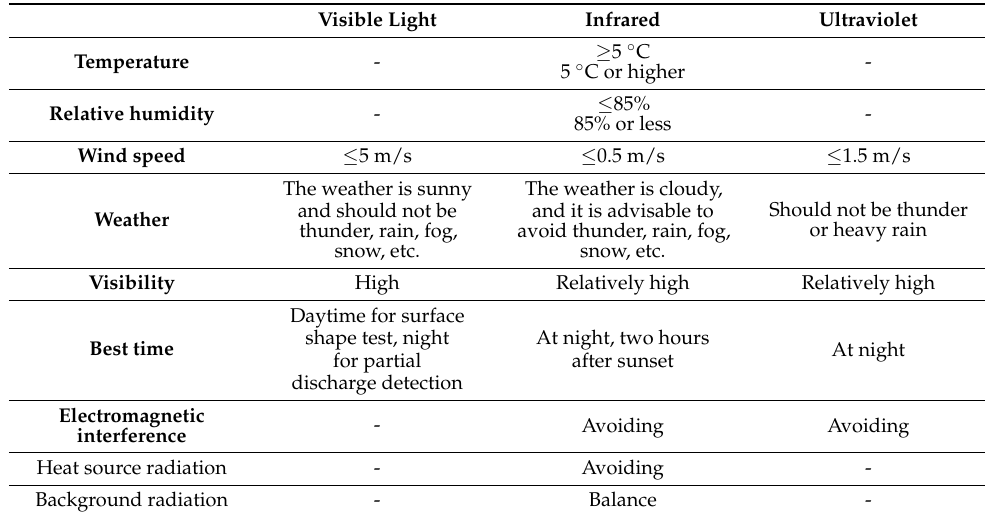
Table 7. Comparison of different detection conditions